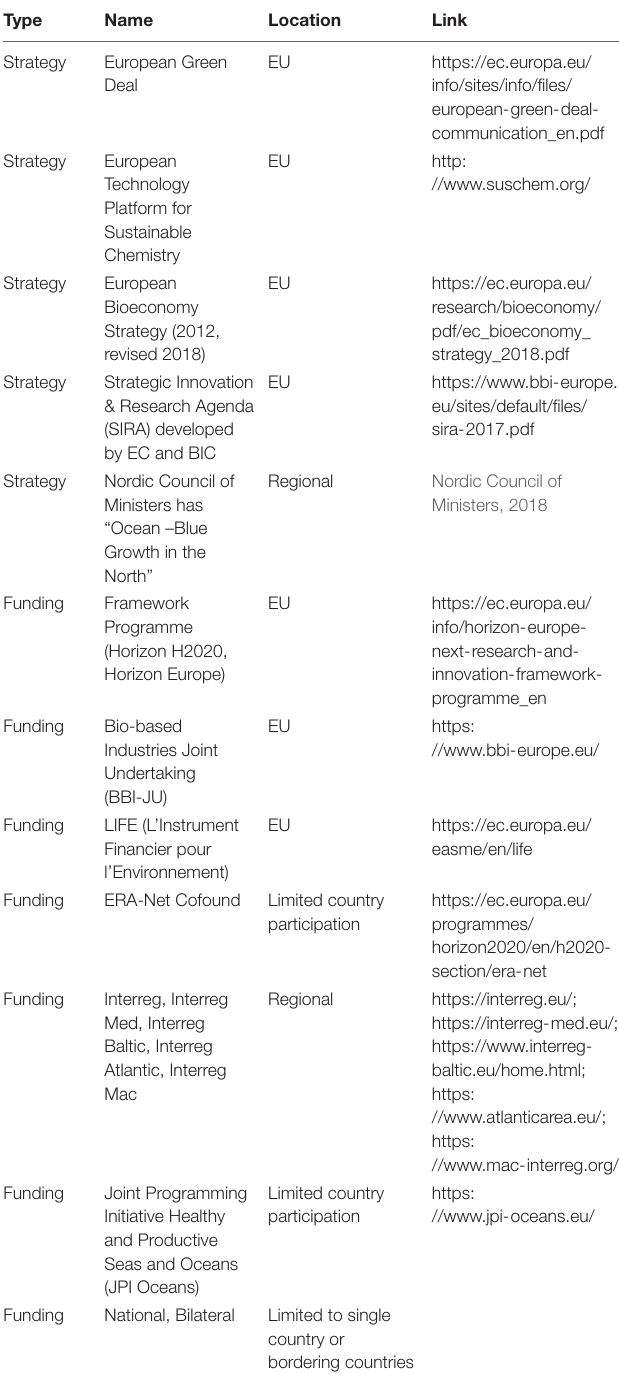
TABLE 4 | A list of European strategies and funding mechanisms that directly or indirectly include marine